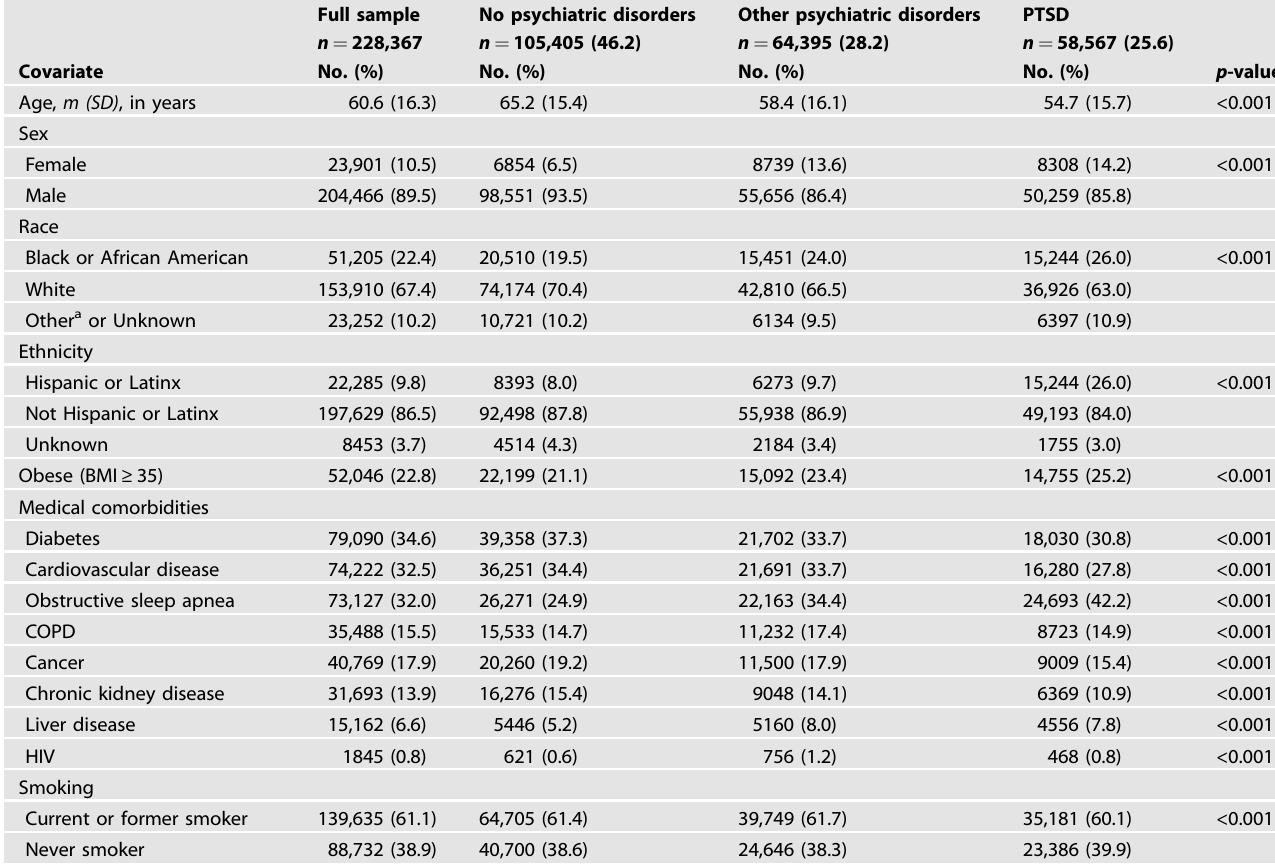
Table 1. Distribution of socio-demographic factors and medical comorbidities among 228,367 VA